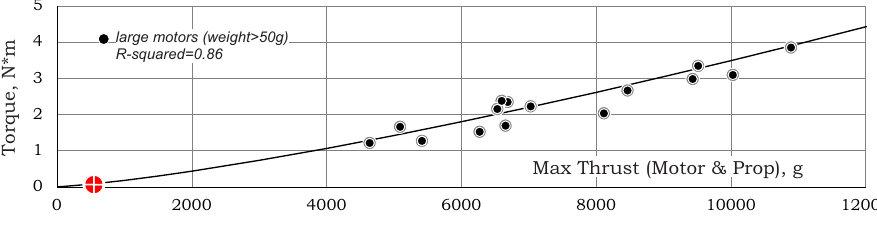
Figure 10. Torque design trend,